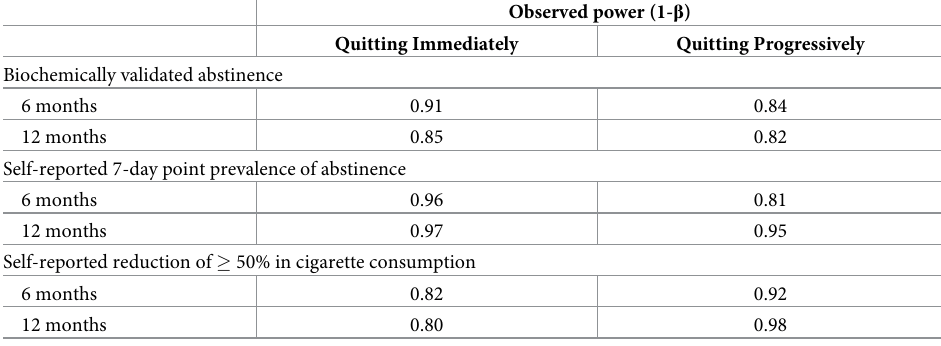
Table 5. Posterior power calculation for quitting immediately (QI) and quitting progressively (QP) compared to smoking cessation leaflet (Control